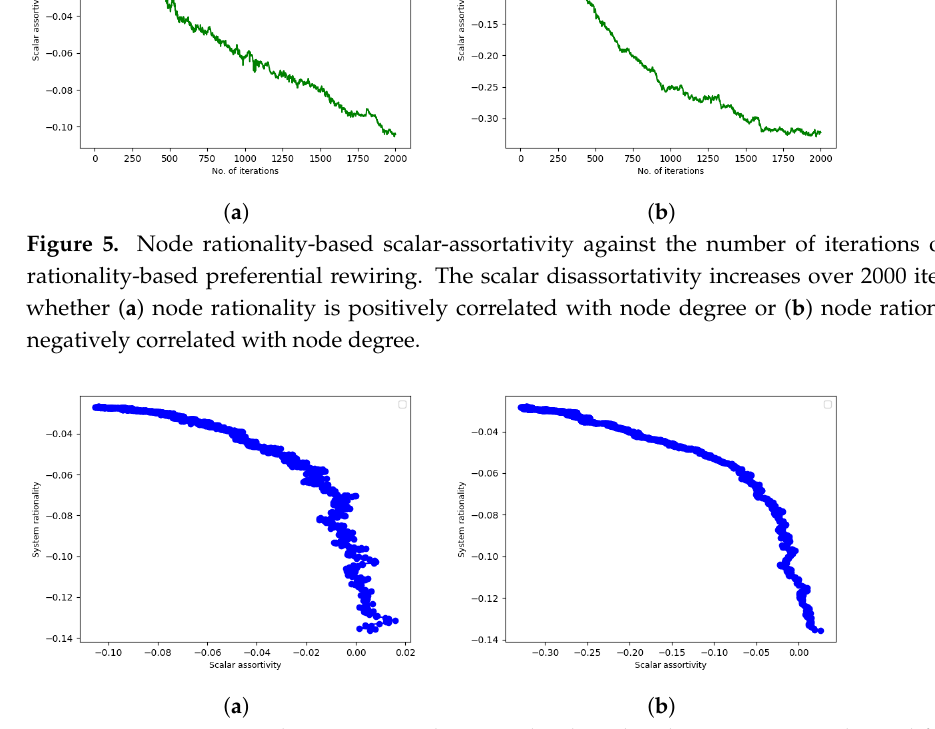
Figure 6. System rationality against node rationality-based scalar assortativity, derived from the intermediate networks obtained when the random topology is rewired to improve the system rationality over 2000 iterations. It can be seen that system rationality is positively correlated with scalar disassortativity whether ( a ) node rationality is positively correlated with node degree or ( b ) node rationality is negatively correlated with node